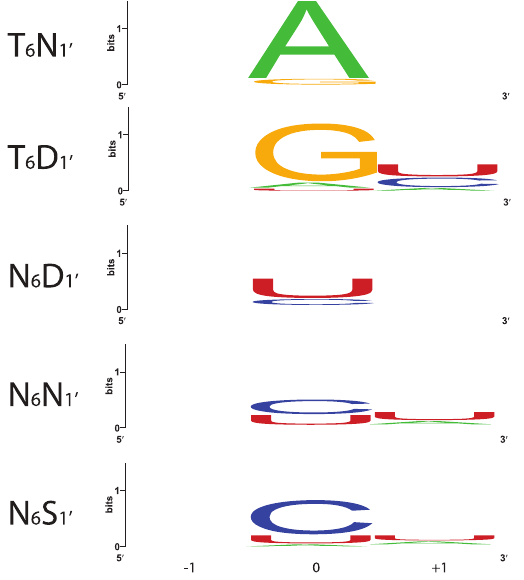
Figure 4. Nucleotides That Align with the Most Frequent Combinations of Amino Acids at Positions 6 and 1 9 . Nucleotides aligned with each 6/1 9 combination in the alignments in Figure S1 were used to construct sequence logos [30]. Only P motifs were used in this analysis. Each logo shows the aligned nucleotide (0) and the preceding ( 2 1) and succeeding ( + 1) nucleotides. 25, 23, 102, 86 and 16 alignments were used to generate the T 6 N 1 9 , T 6 D 1 9 , N 6 D 1 9 , N 6 N 1 9 and N 6 S 1 9 logos,